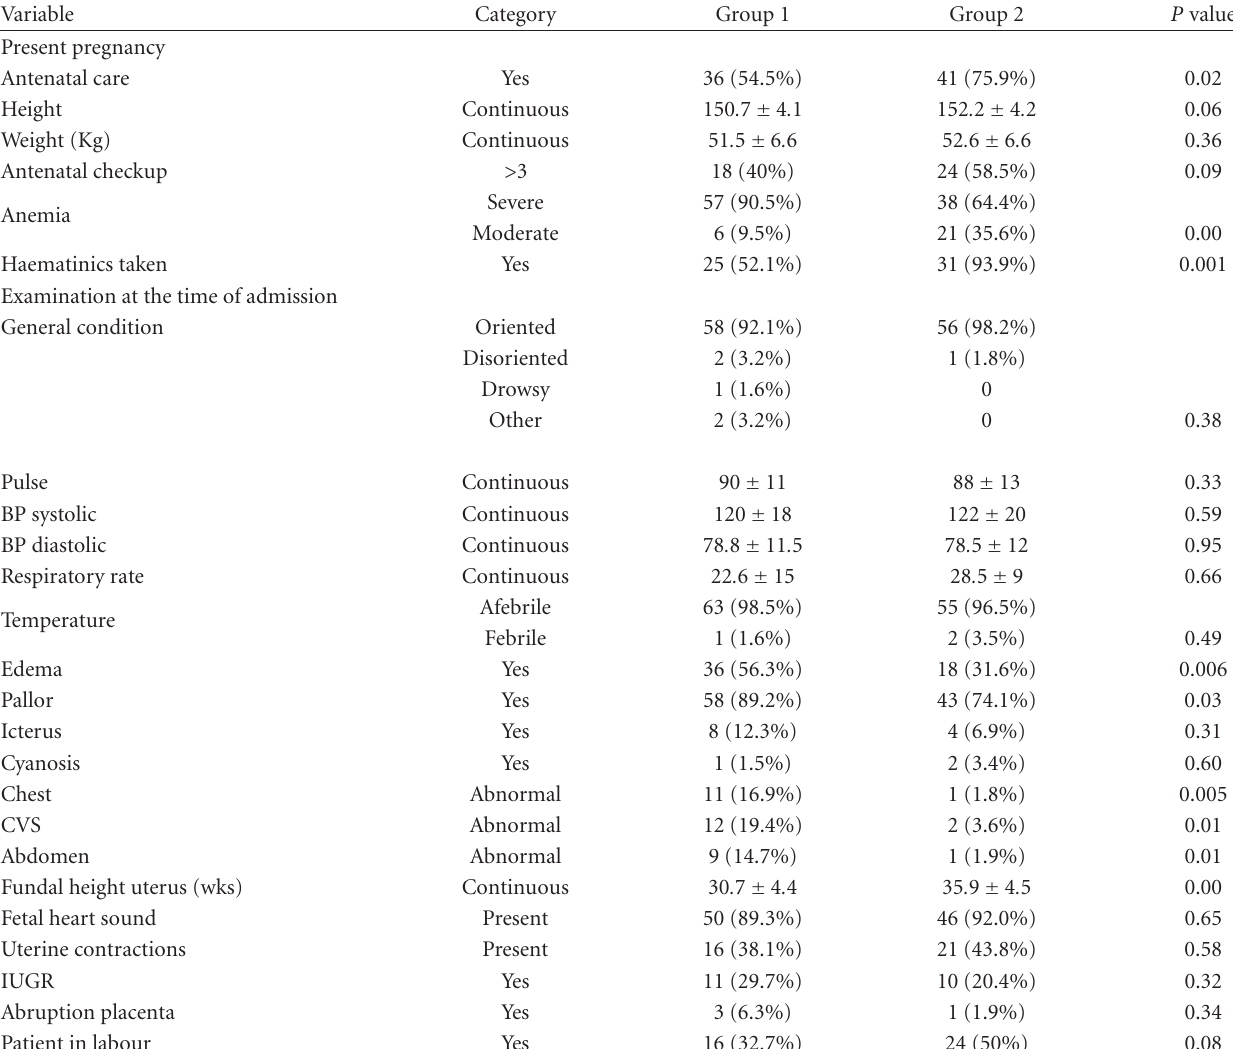
Table 2: Nonclinical/medical characteristics of anemic pregnant